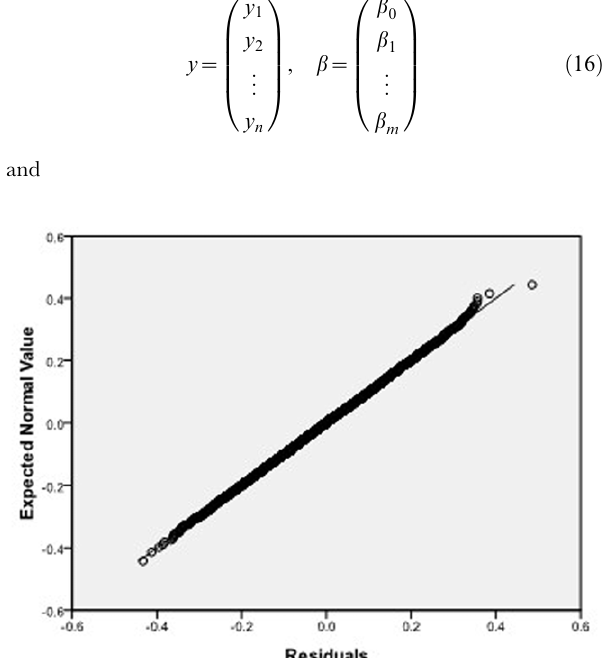
Figure 26. Histogram and asymptotic distribution for ^ bb 1 of OLS when the variance function of the error term is z x 2 )) . 1 2